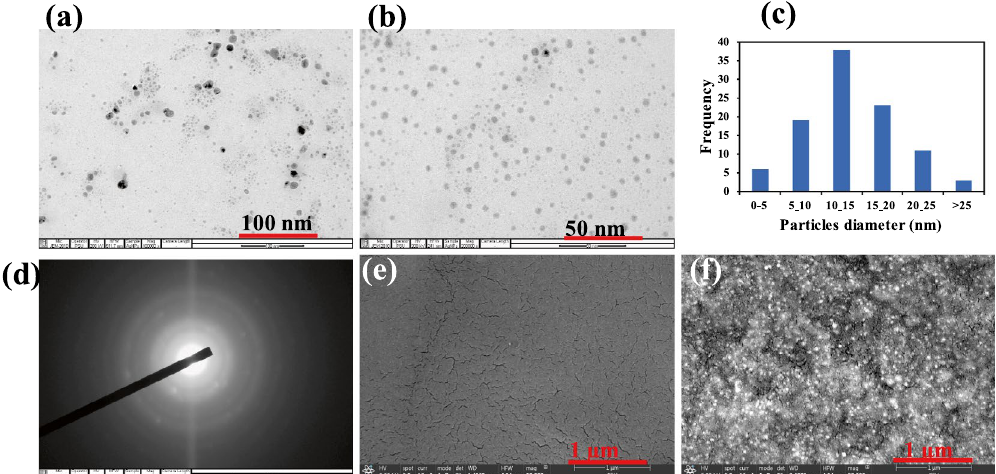
Figure 3. TEM images of KgM-AgNPs at ( a ) 100 nm and ( b ) 50 nm ( c ) Particles size distribution obtained from ImageJ software (ImageJ-1.38e: https:// imagej. nih. gov/ ij), ( d ) Selected area electron diffraction (SAED), FESEM images of ( e ) KgM and ( f )